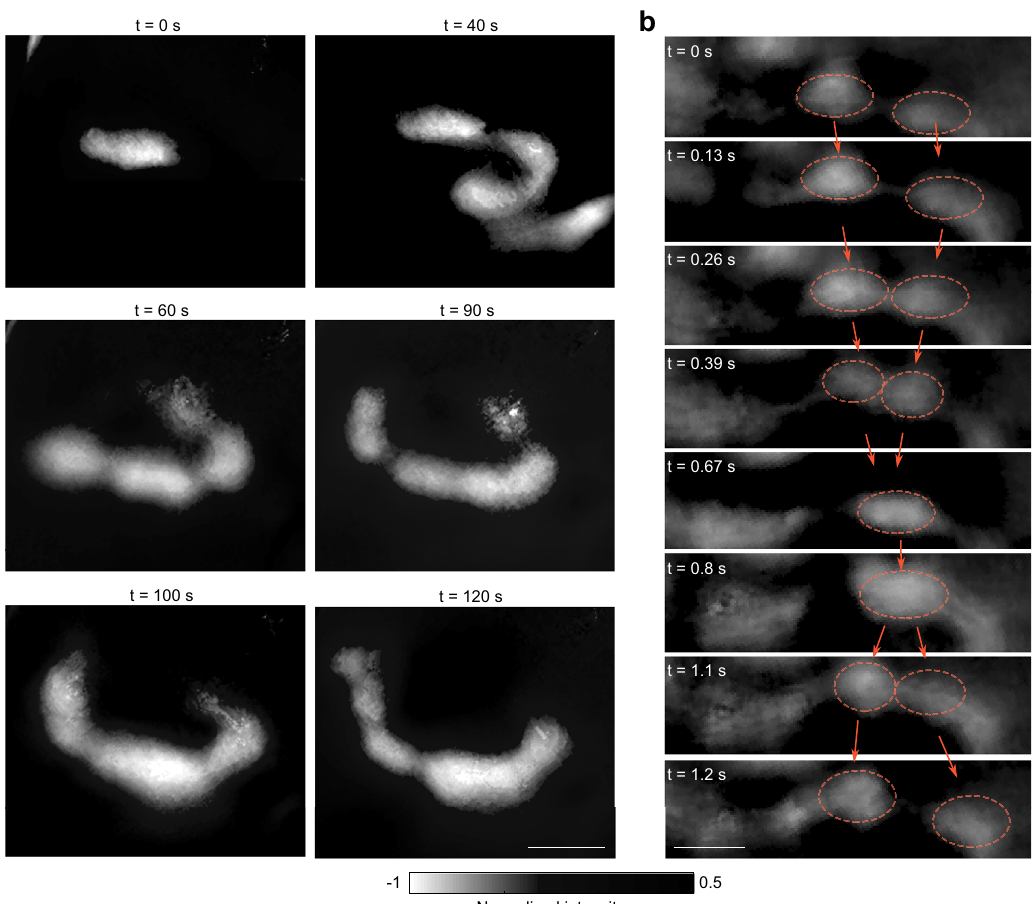
Fig. 3 Detailed movement of the intestine revealed by 2D-TIP, showing typical pacemaker-driven peristalsis and segmentation. a Representative 2D- TIP frames within a 120 s time window demonstrating the propagation of contrast agent inside the intestine, driven by a peristaltic motor pattern. b 2D-TIP frames showing a typical intestinal segmentation motor pattern. Scale bar: 5